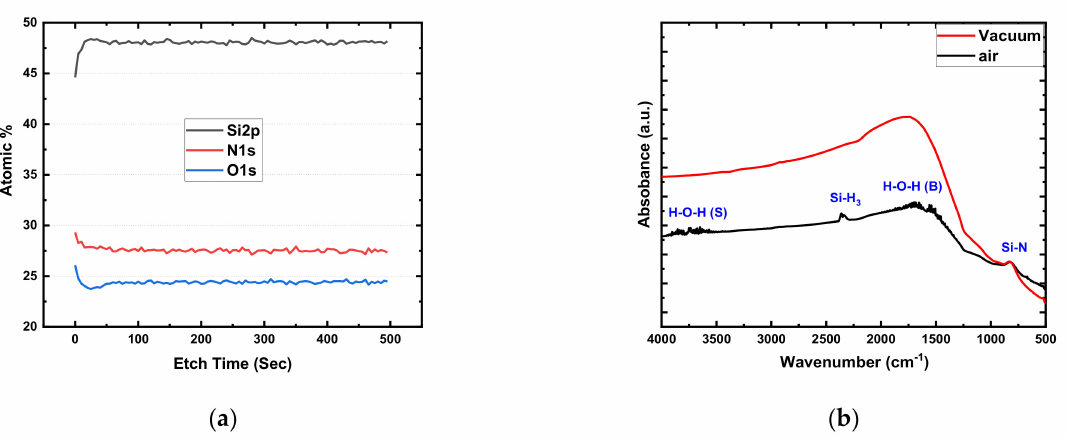
Figure 1. Compositional analysis of SiO x N y thin film: ( a ) XPS depth profile with atomic percentages; ( b ) FTIR absorbance spectra measured in open-air and vacuum